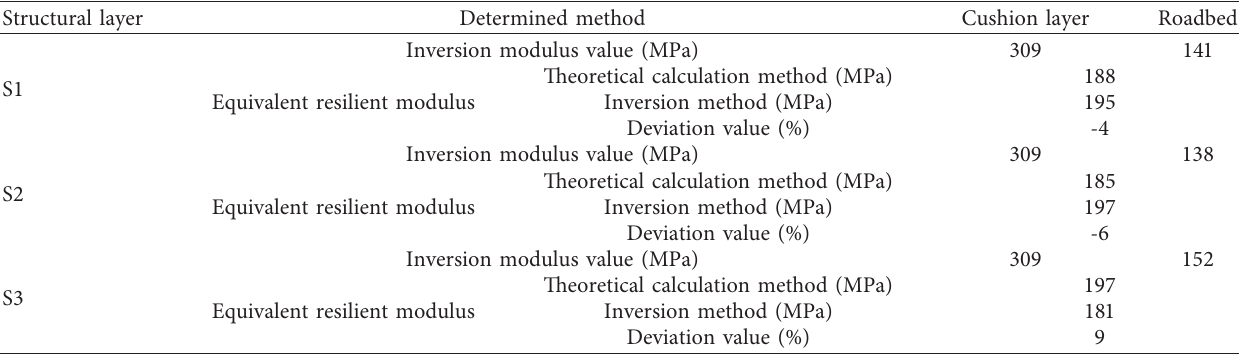
Table 4: Determination of equivalent resilient modulus of cushion top surface based on road surface deflection. Structural